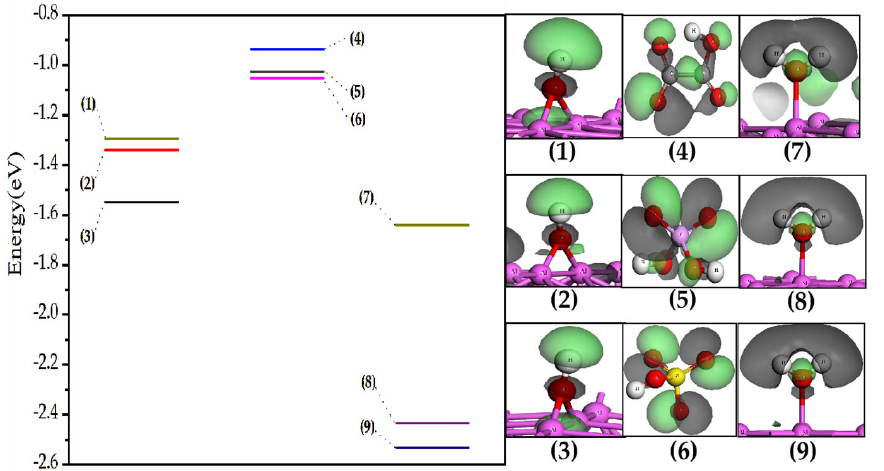
Figure 4. The energy levels and shapes of H in OH adsorbing on the anodic aluminum slabs: ( 1 ) (111) +1 , ( 2 ) (110) +1 , ( 3 ) (100) +1 ; the energy levels and shapes of HOMO of acid radicals: ( 4 ) HCO 4 − , ( 5 ) H 2 PO 4 − , ( 6 ) HSO 4 − ; the energy levels and shapes of H in H 2 O adsorbing on the anodic aluminum slabs: ( 7 ) (110) +1 , ( 8 ) (100) +1 , ( 9 ) (111) +1